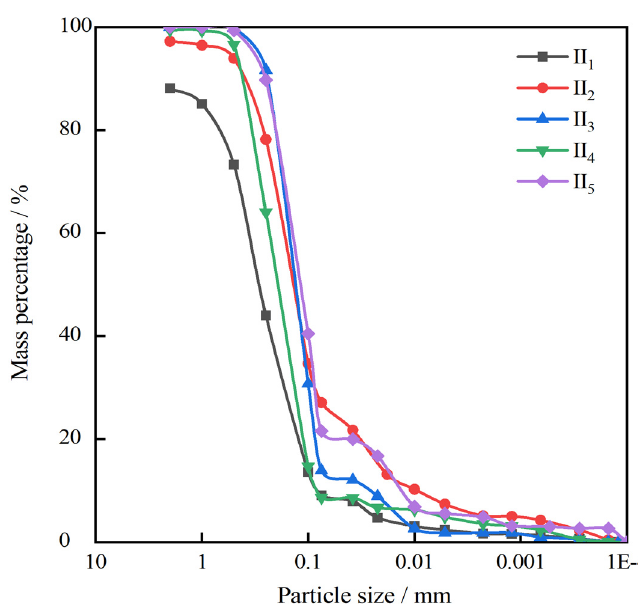
Figure 3. Ore drawing mouth 2.